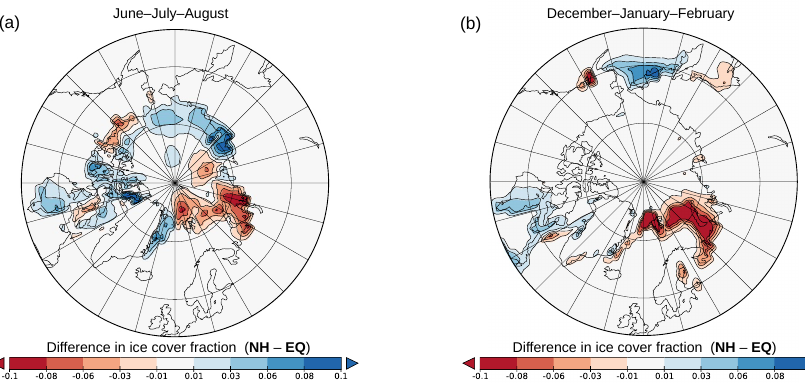
Figure 9. Difference in the ice cover fraction between scenarios NH and EQ in (a) June–July–August and (b) December–January–February. The blue regions show where the ice cover is larger in scenario NH than in EQ. The red regions shows where ice cover is